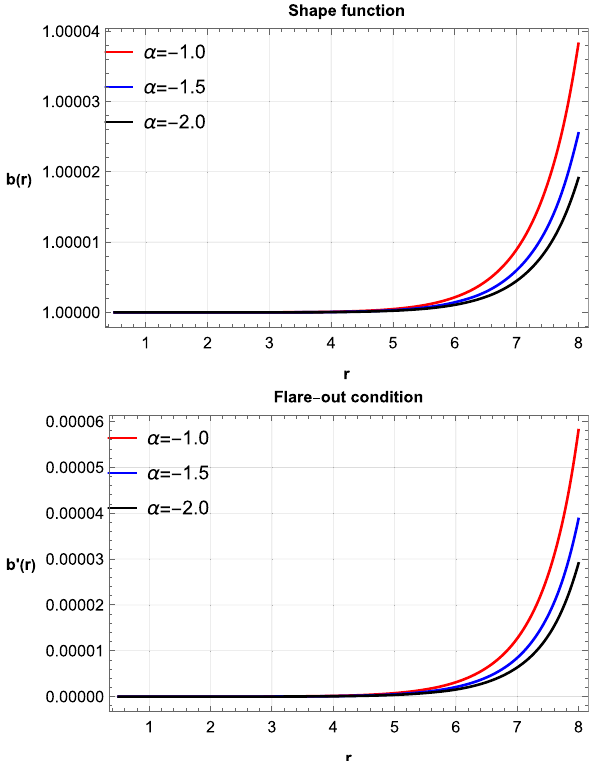
Fig. 14 The EoS parameter ω for two sphere (case-2) with r 0 = 1, D = 20 and vanishing β = 0